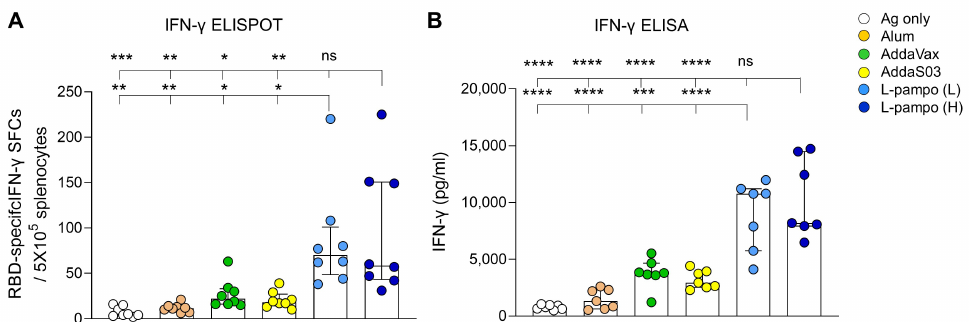
Figure 2. RBD and S1 antigens with L-pampo induce strong cell-mediated responses. ( A , B ) BALB/c mice (total n = 48, n = 8/group in ( A ); total n = 42, n = 7/group in ( B )) were immunized with SARS-CoV-2 antigens (RBD and S1) with or without adjuvants i.m. on day 0 and day 14 as described in Figure 1A. On day 28, splenocytes were stimulated with the PepMix TM SARS-CoV-2(S-RBD) peptide pool, and RBD-specific IFN-γ secreting cells were analyzed as spot-forming cells (SFCs) by ELISPOT assay ( A ) or total IFN-γ production by ELISA assay ( B ). Data shown are median ± IQR. Each dot represents an individual mouse. Data reflect 2 independent experiments (n = 4/group in single experiment). Asterisks indicate statistically significant differences in comparison to the L-pampo (L) or L-pampo (H) groups. * p < 0.05; ** p < 0.01; *** p < 0.001; **** p < 0.0001; ns, non-significant, one way ANOVA with Tukey’s test.